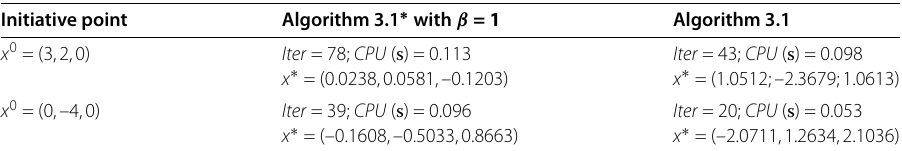
Table 1 Results for Example Algorithm 3.1 ∗ with β = 1 Algorithm